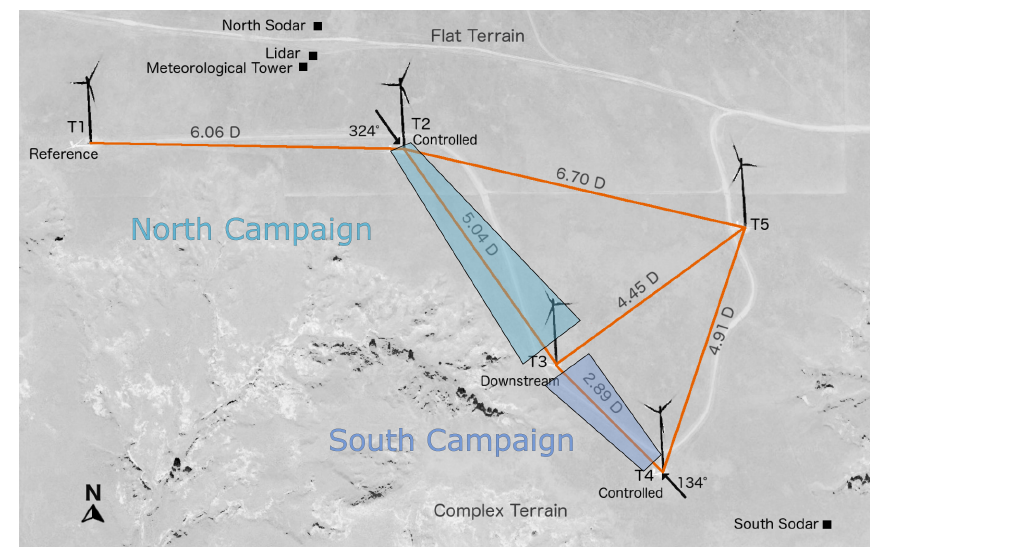
Figure 1. Layout of the experimental site. Turbine 2 (T2) and Turbine 4 (T4) have wake steering implemented to benefit Turbine 3 (T3), whereas Turbine 1 (T1) and Turbine 5 (T5) are reference turbines. The position of the installed meteorological equipment is also shown. Finally, the complexity of the terrain to the south and flat terrain to the north are indicated. © Google